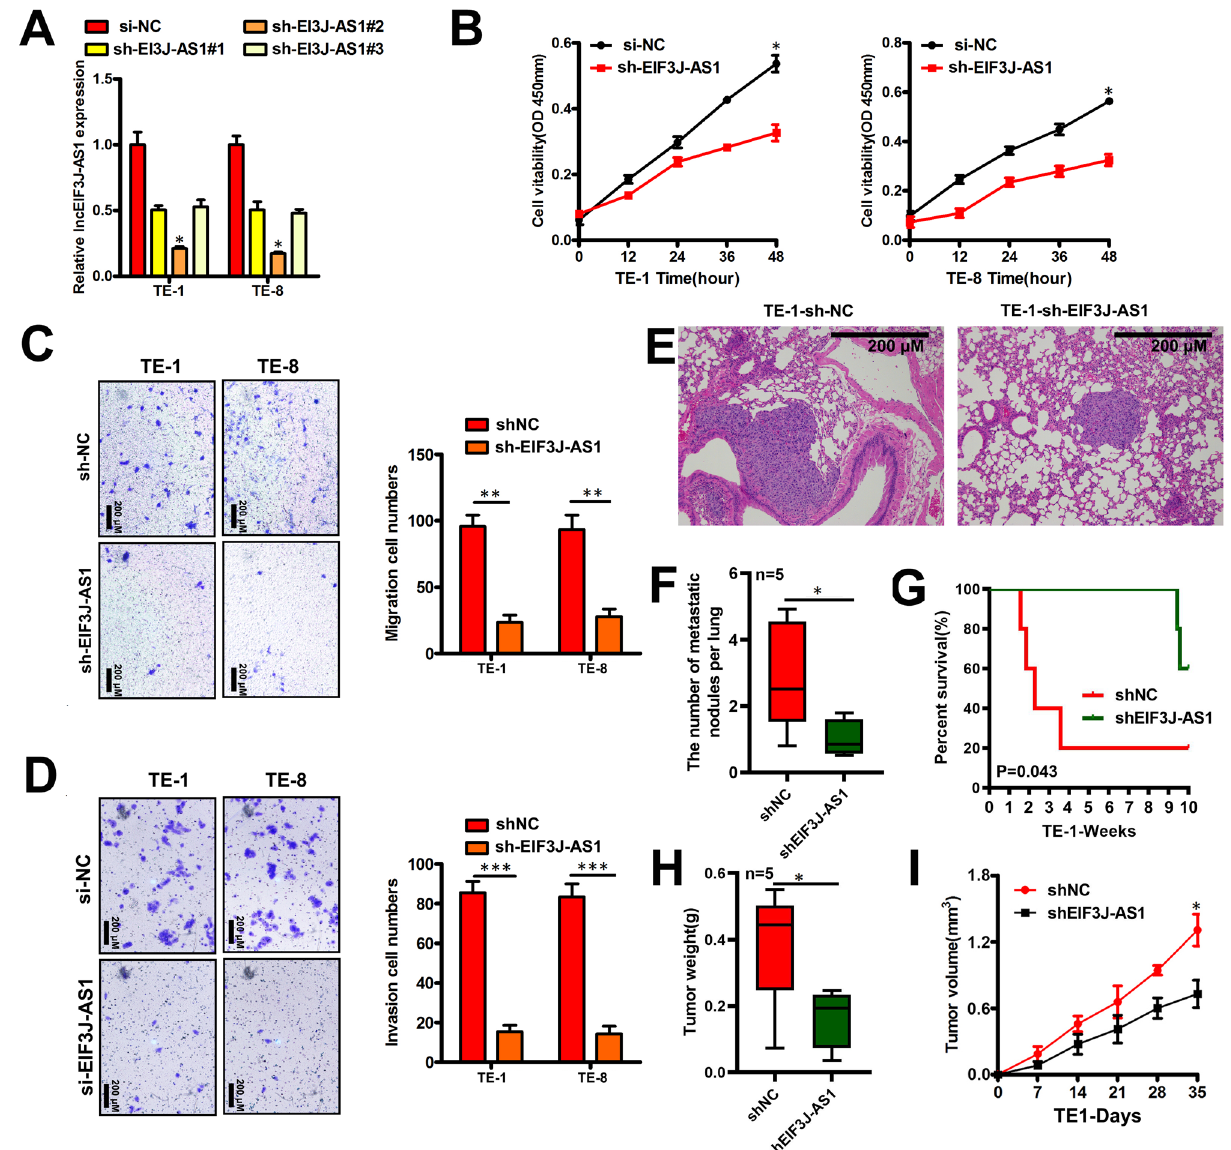
Figure 2. Effects of EIF3J-AS1 Knockdown on ECa cells growth and metastasis. ( A ) RT-qPCR analysis of EIF3J-AS1 expression in indicated ECa cells after the transfection of sh-EIF3J-AS1 or sh-NC. ( B ) The proliferation of EIF3J-AS1 deficient-indicated ECa cell was detected using the Cell Counting Kit-8 assay. ( C , D ) Transwell assays were performed to assess the migratory and invasive abilities of Indicated ECa cells following sh-EIF3J-AS1 or sh-NC transfection. ( E ) H & E staining of mouse lung tissues from indicated treated group. ( F ) Numbers of metastatic foci observed in each group (n = 5). ( G ) Comparisons of the OS curves of mice by Kaplan–Meier survival analyses. ( H , I ) Indicated treated ECa cells were subcutaneously injected into nude recipient mice (n = 5). *P < 0.05; **P < 0.01; ***P <